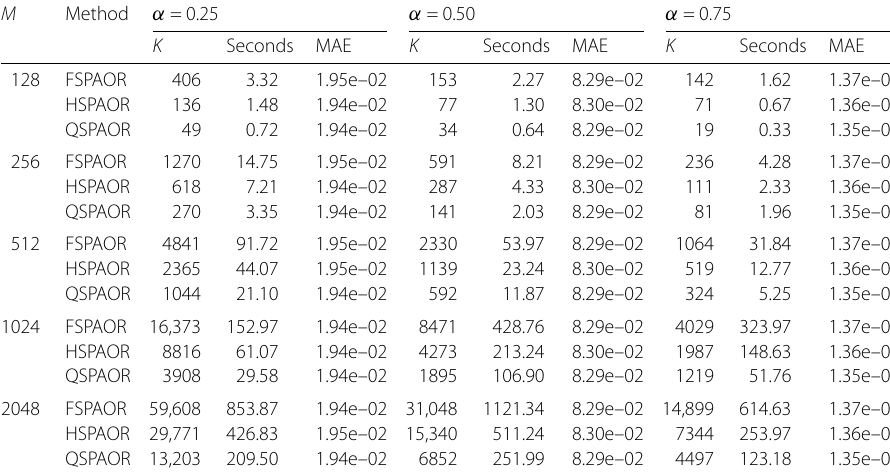
Table 2 Numerical results for Example